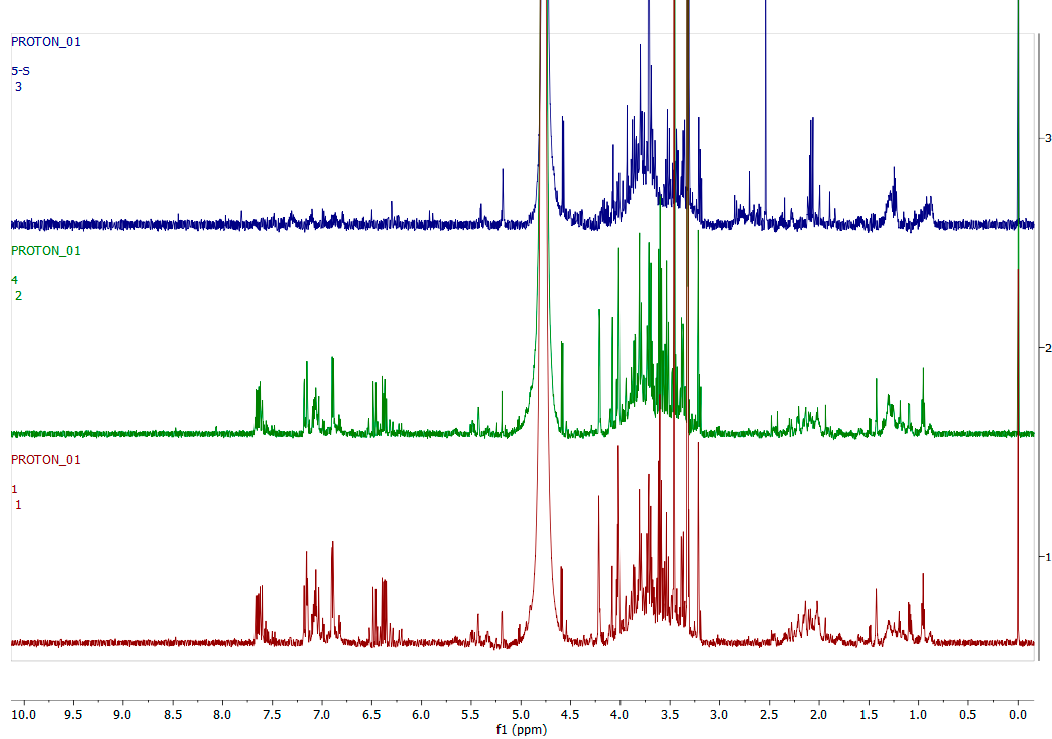
Figure 8. The 600 MHz 1 H-NMR spectra of H. aureonitens leaf extracts collected from the wet and dry sites at Telperion during the spring season. Red = site 1 (wet); green = site 2 (wet); blue = site 3 (dry).